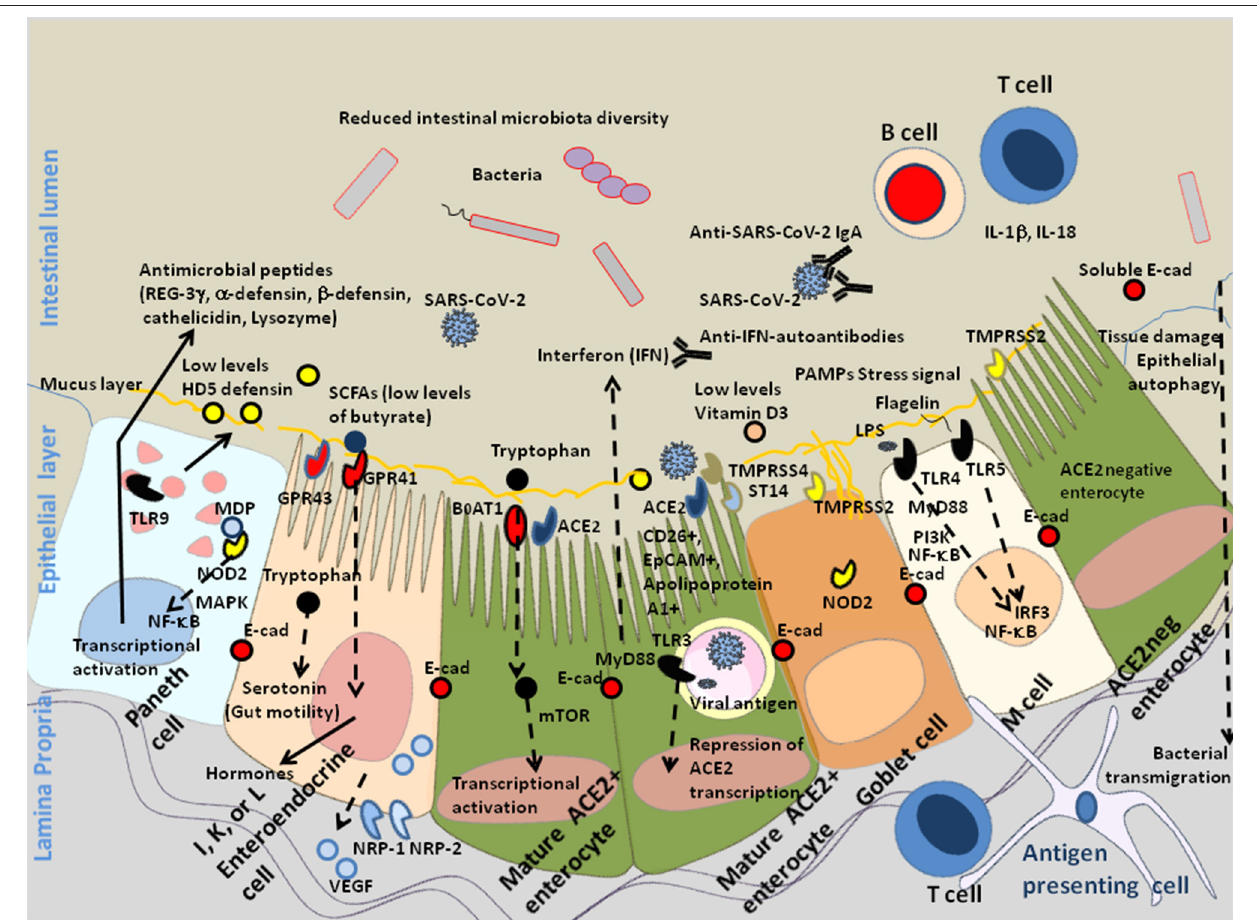
FIGURE 2 | Schematic diagram of SARS-CoV-2 infection of mature enterocytes and consequences on intestinal dysbiosis. Different cell types (enterocytes, Paneth cells, globet cells, M, cells, enteroendocrines cells, tuft cells) interact together through tight junctions (homotypic interactions of E-cad in trans) to form a continuous epithelial barrier isolating the luminal content from the internal tissues. The goblet cells secrete the mucins (e.g., MUC2–mucin gel) in the hope of protecting the intestinal epithelium by reducing bacteria attachment while allowing nutrients to be processed by enterocytes. The Paneth cells produce antimicrobial proteins, in response to infection. The enteroendocrines epithelial cells express the FFA2/GPR43 and FFA3/GPR4 surface receptors that bind the SCFAs and trigger signal leading to the regulation of the glucose homeostasis and the secretion of hormones influencing appetite; these cells also express the NRP-1 receptor and produce VEGF. The main role of enterocytes is to ensure absorption of nutriments. Uptake of tryptophan depends on B 0 AT1. ACE2, expressed by enterocytes is necessary for the surface expression of the amino acid transporter B 0 AT1 in the intestinal epithelium. ACE2 mRNA expression is strongly reduced in cells infected by SARS-CoV-2. In the microenvironment where the infection occurs, the villous microfold cells (M cells) expressing the toll-like receptors/TLR detect stress signals, tissue damages, and PAMPs (e.g., lipopolysaccharide /LPS from Gram negative bacteria recognized by TLR-4 and its co-receptor CD14, flagellin, peptidoglycan, lipoproteins, and unique bacterial nucleic acid structures), have a pivotal role in antigen presentation, they uptake antigens from the luminal content, transport (transcytosis and microvesicle uptake), these antigens to their basolateral membrane where they are delivered to the underlying immune cells of the gut-associated lymphoid tissues (GALT), including KLRG1 + dendritic cells and monocytes/macrophages, CD103 + T-cells, KLRG1 + T-cells, and other immune cell subpopulations, which colonize the lamina propria. After their priming, the immune response cells migrate to the site of infection to counteract the pathogen invasion. The doublecortin like kinase 1 (DCLK1 + ) tuft cells also contribute to innate immunity (i.e., they recognize protozoan and helminth antigens) and produce IL-25 that activate innate lymphoid cells (ILC2) at inducing IL-13 production. It is likely that a decrease in butyrate (protective function) is a consequence of SARS-CoV-2-associated reduced diversity of microbiota. In addition, COVID-19 patients produce less HD5, thereby reducing the overall antibacterial defense. Due to the dysbiosis, stress signals, tissues damages, and recognition of bacterial peptidoglycan-conserved motifs, muramyl dipeptide, and MDP sensed by the nucleotide-binding oligomerization 2 (NOD2) are likely to regulate the production of cytokines IL-1 β and IL-18 aimed at restricting bacterial replication and to provoke pro-inflammatory reactions [see review (137) for details]. The activation of cellular and bacterial sheddases reduces the epithelium surface expression of E-cad at the site of infection, resulting in the destruction of adherent’s junctions and allowing pathogens’ transmigration. We previously speculated that the induction of E-cad on subpopulation of immune response cells (E-cad + T-cells and CD16 + /E-cad + monocytes) redirects those cells far from the infection site. The release of sE-cad might also serve as a decoy for